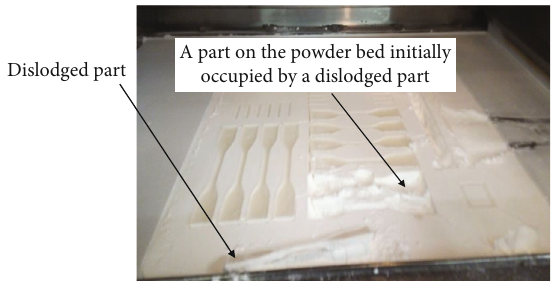
Figure 5: Dislodged parts due to